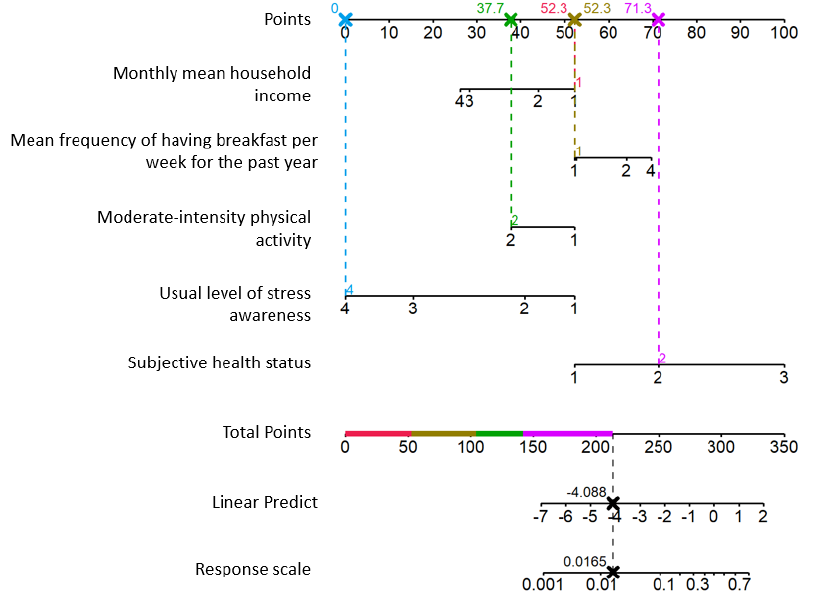
Figure 2. Application Example of Depression Prediction Nomogram for Older adults Living Alone: older adults who responded that mean monthly household income was less than KRW 1.5 million, mean frequency of having breakfast per week for the past year was 5–7 times a week, did not do moderate-intensity physical activity, and hardly felt stressed.